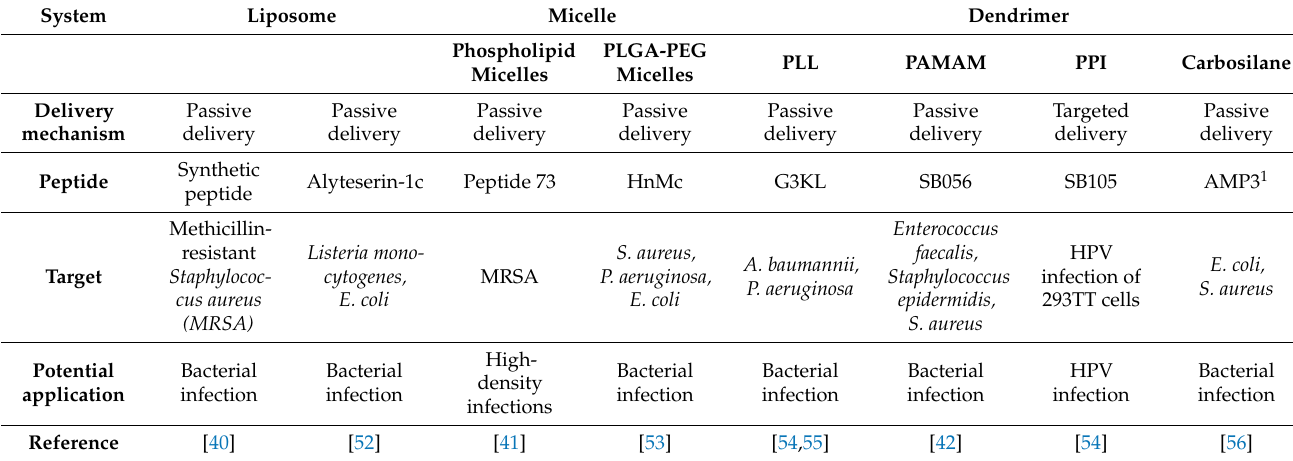
Table 1. An overview of liposomes, micelles, and dendrimers as nanodrug delivery systems for AMPs and their potential applications for treatment of